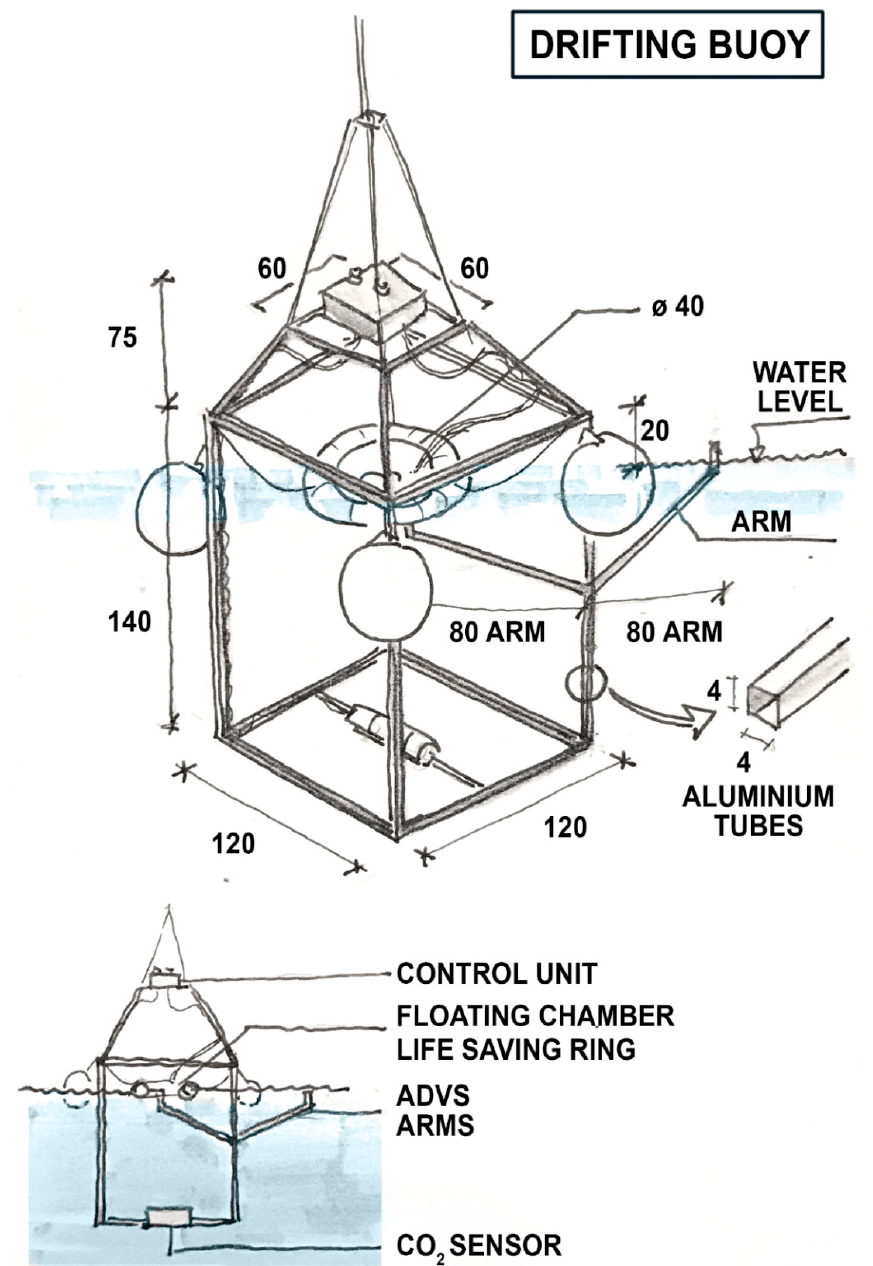
Figure 1. Diagram of the Sniffle, an autonomous drifting buoy with floating chamber to measure ocean-atmosphere CO 2 fluxes. Its main components are the control unit, the floating chamber, two acoustic Doppler velocimeters and the CO 2 sensor. The dimensions are in cm. In short, we used the floating chamber technique and measured the turbulence inside and outside the chamber simultaneously to see if turbulence affected the measurements. Furthermore, we